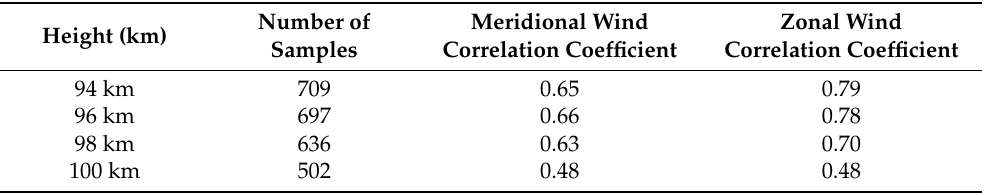
Zonal Wind Correlation Coefficient